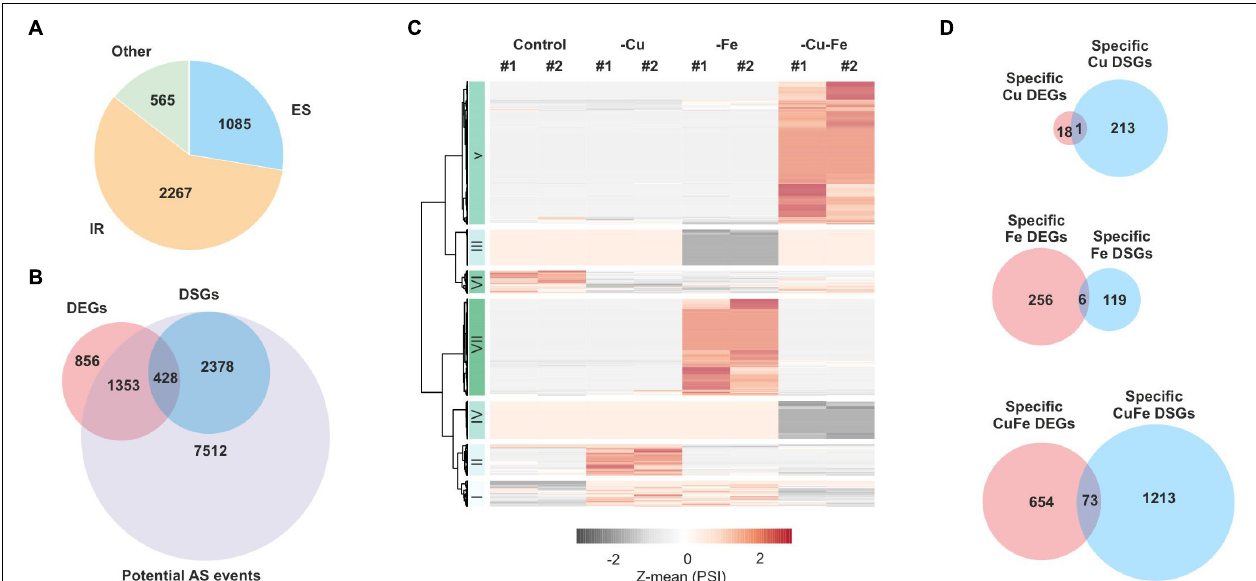
FIGURE 1 | Analysis of differential splicing events under individual and simultaneous copper and iron deficiency. RNA-Seq read counts covering exonic and intronic regions from the transcriptome profiles of rosette leaves treated for single and double copper and iron deficiency reported in Garcia-Molina et al. (2020) were obtained with the ASpli package (see “Materials and Methods”). (A) Classification of AS events into intron retention (IR), exon skipping (ES) or other events (Other). (B) Euler diagram comparing the fraction of all genes potentially affected by AS, the differentially spliced genes (DSGs) detected and differentially expressed genes (DEGs) reported in Garcia-Molina et al. (2020). (C) Heatmap with hierarchical clustering according to the Ward D2 method with Z-mean for significant changes in percentage of intron retention or bin inclusion (represented as PSI) ( p -value ≤ 0.05, two-way ANOVA) under standard conditions (control), copper (–Cu) and iron (–Fe) deficiency or double deficiency (–Cu–Fe). (D) Euler diagrams comparing the fraction of specific DEGs in Garcia-Molina et al. (2020) and specific DSGs for each treatment. Specific DEGs and DSGs were defined as the common fraction in multiple comparisons among significant changes in each of the conditions (absolute fold-change ≥ 2 in pair-wise comparisons, adjusted- p -value ≤ 0.05, Tukey’s test; Supplementary Figure 1